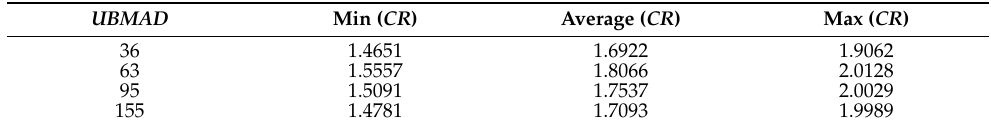
Table 2. Dependence of the minimum, maximum, and average values of CR on UBMAD for the case of DAT1 of depth 5.